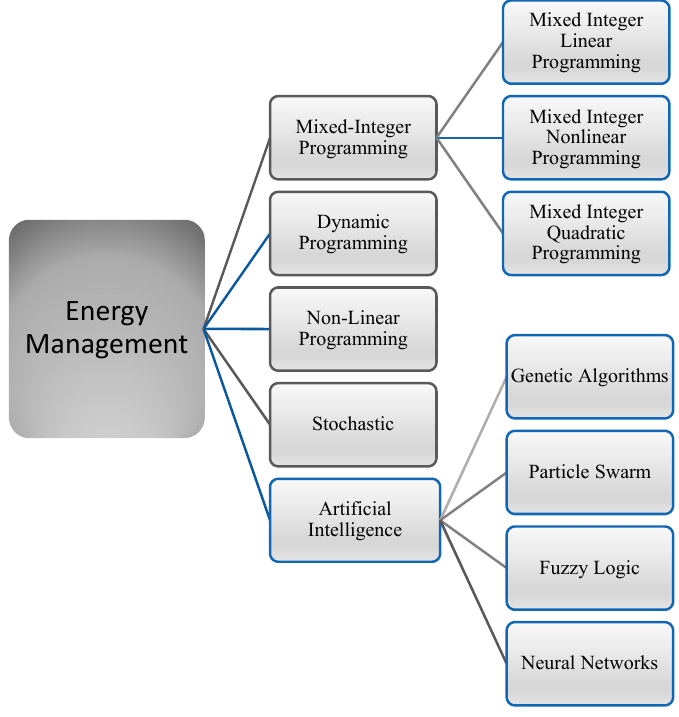
Figure 3. Energy management methodologies in microgrids (MGs) [25].